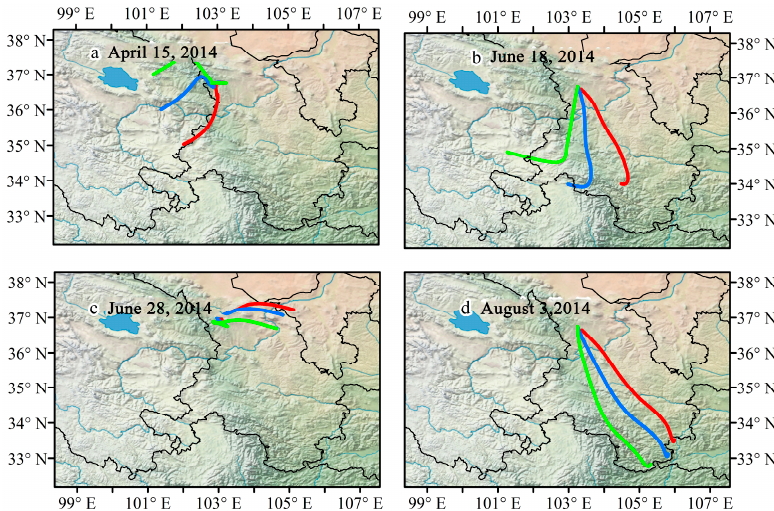
Figure 5. Backward trajectories for four typical rainfall events during the past 24 h: ( a ) 15 April 2014, ( b ) 18 June 2014, ( c ) 28 June 2014, and ( d ) August 3, 2014. The green, blue and red lines denotes the target heights of 500, 1000 and 1500 m, respectively.